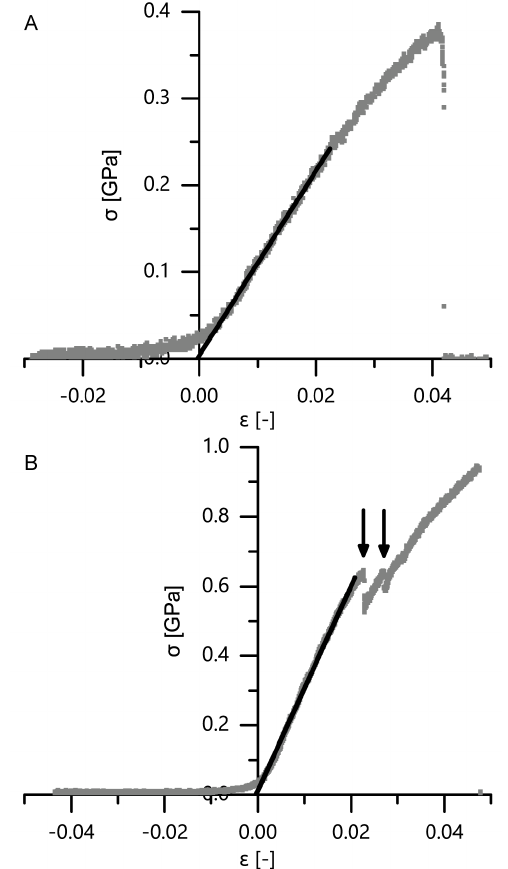
Figure 14. Exemplary stress–strain curves of microtensile tests on a single extracted single bark fiber of the outer bark ( A ) and an extracted pair of interconnected bark fibers of the outer bark ( B ). Whereas typically no prefailure events were observed during tensile tests on single bark fibers, such prefailure events were abundant during tensile tests of fiber pairs (marked with arrows). The black lines in the graphs indicate the slope of the best-fit line of the initial linear range used to determine zero